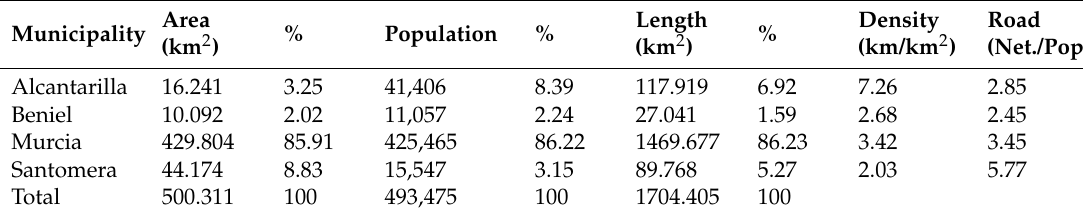
Table 4. Morphometry of the network in the study